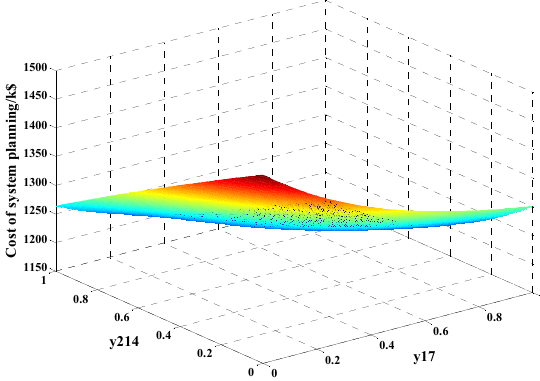
Figure 7. The value of C DG impace with y 17 and y 214 .